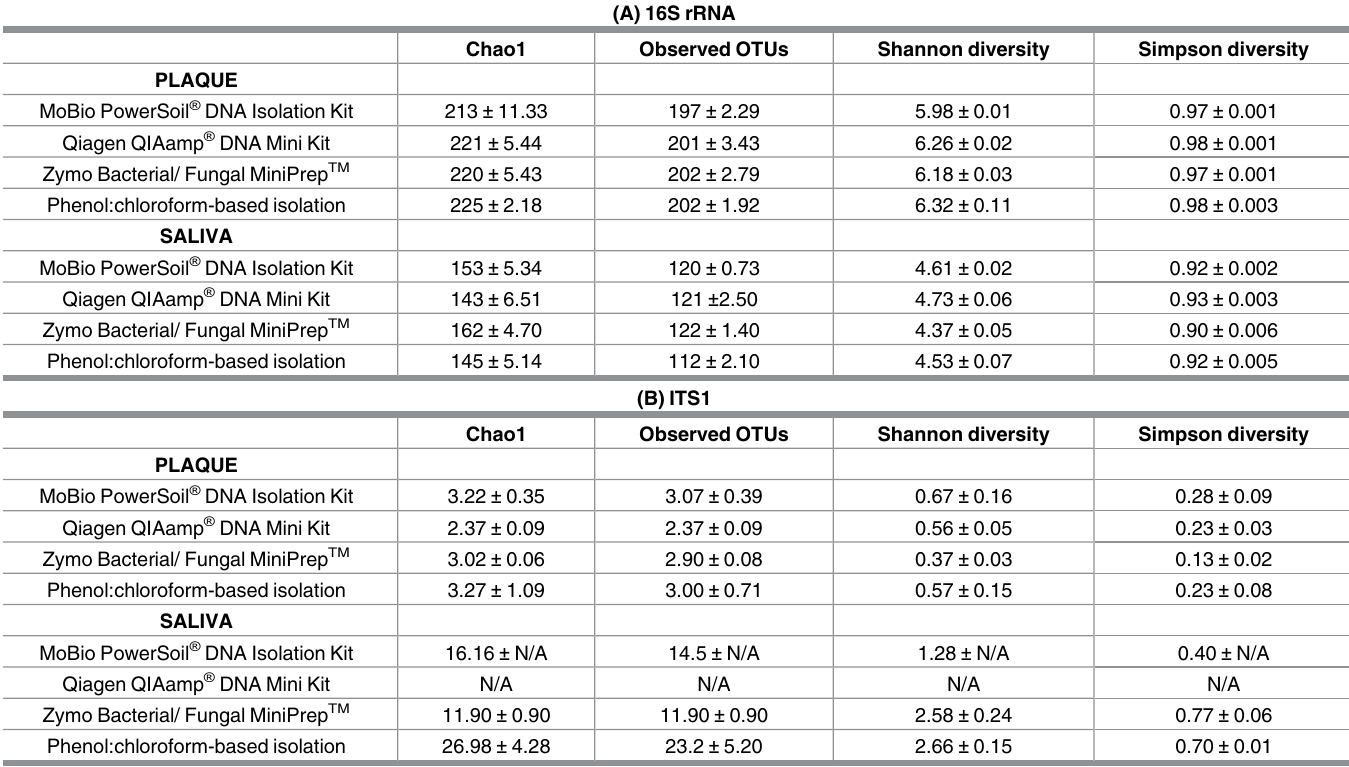
Table 2. Alpha diversity measurements (mean ± SEM) for triplicate data from each of the four DNA extraction methods, amplified with 16S rRNA gene primers (A) and ITS1 primers (B). (A) 16S rRNA Chao1 Observed OTUs Shannon diversity Simpson